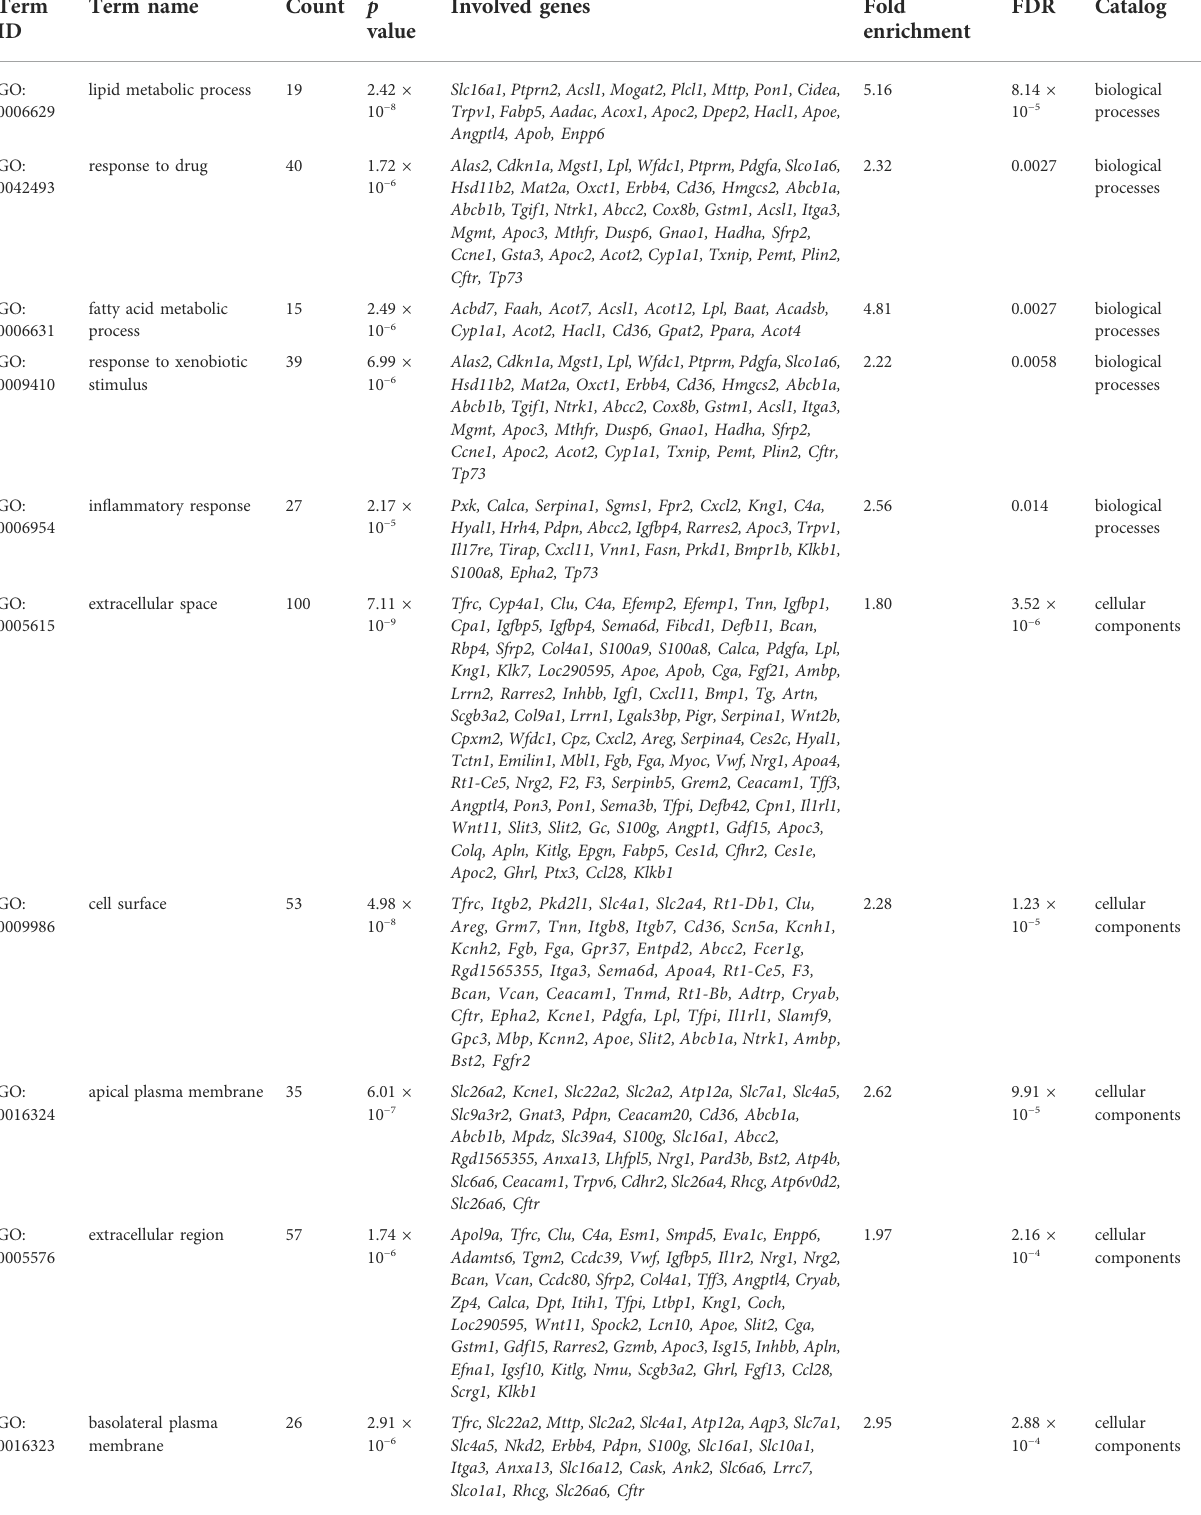
TABLE 2 Top 5 enriched GO terms in each catalog associated with differentially expressed genes in Bailing capsule-treated group vs. DN group ( p < 0.001). Term